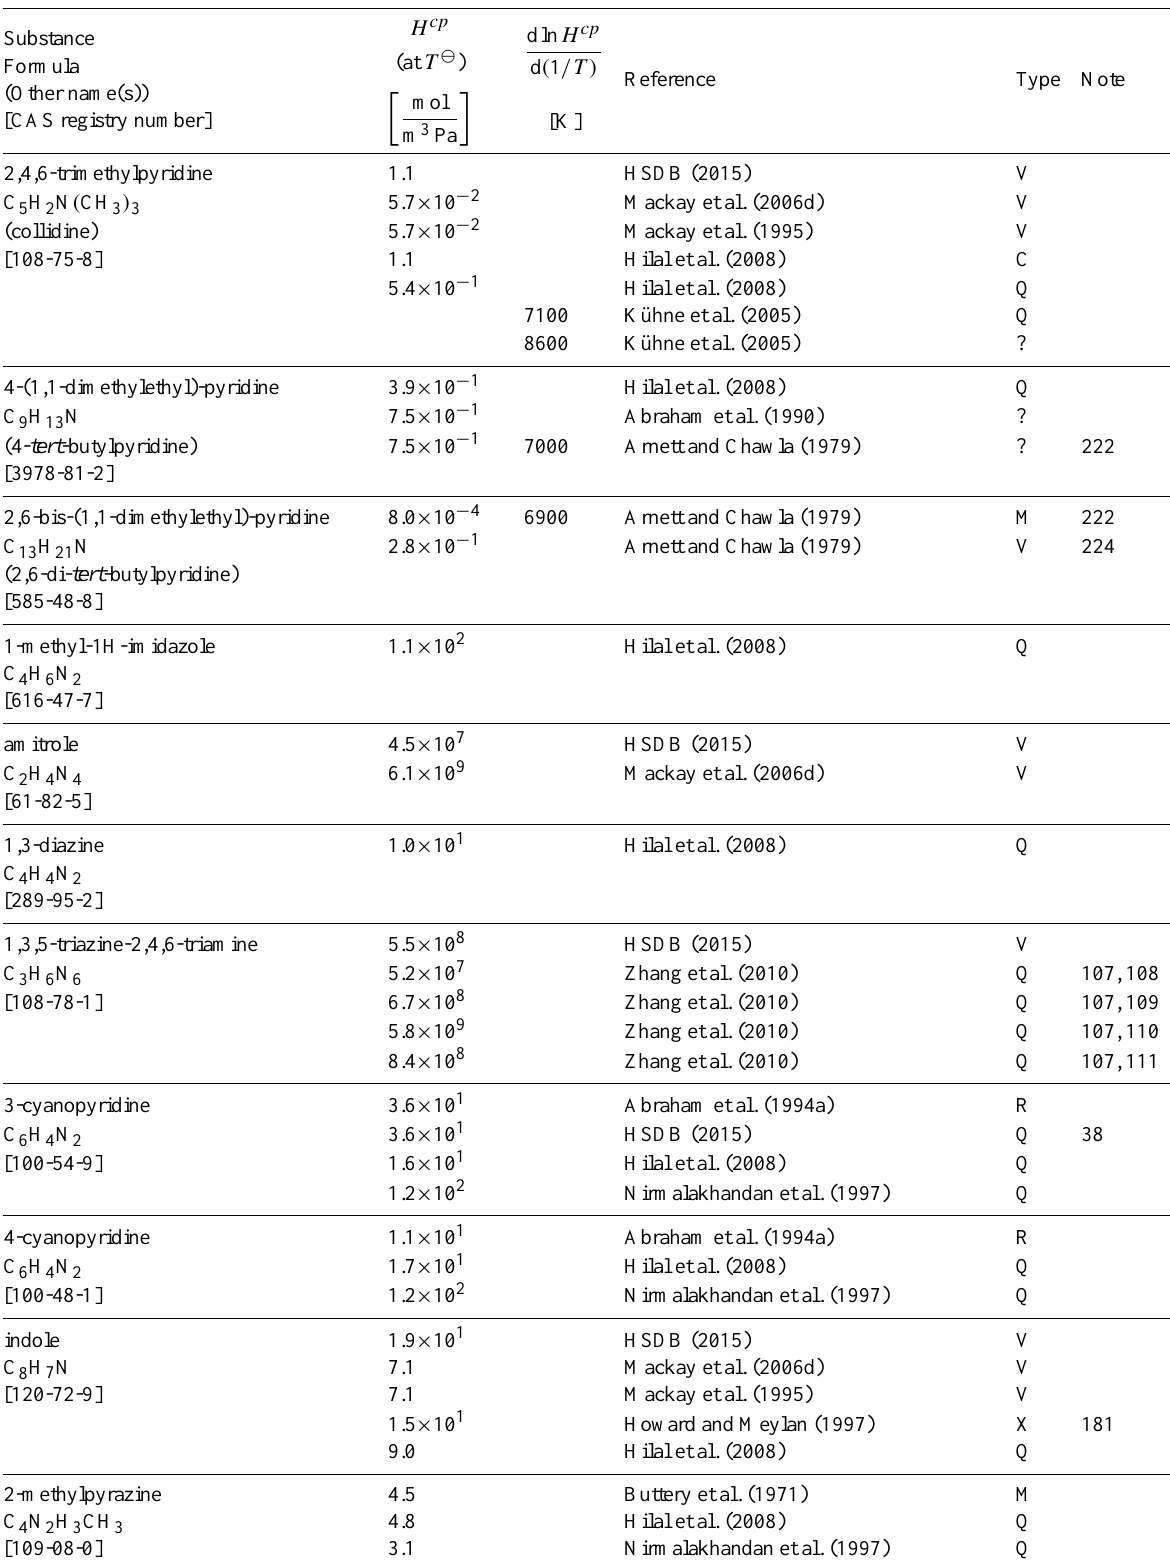
Table 6: Henry’s law constants for water as solvent